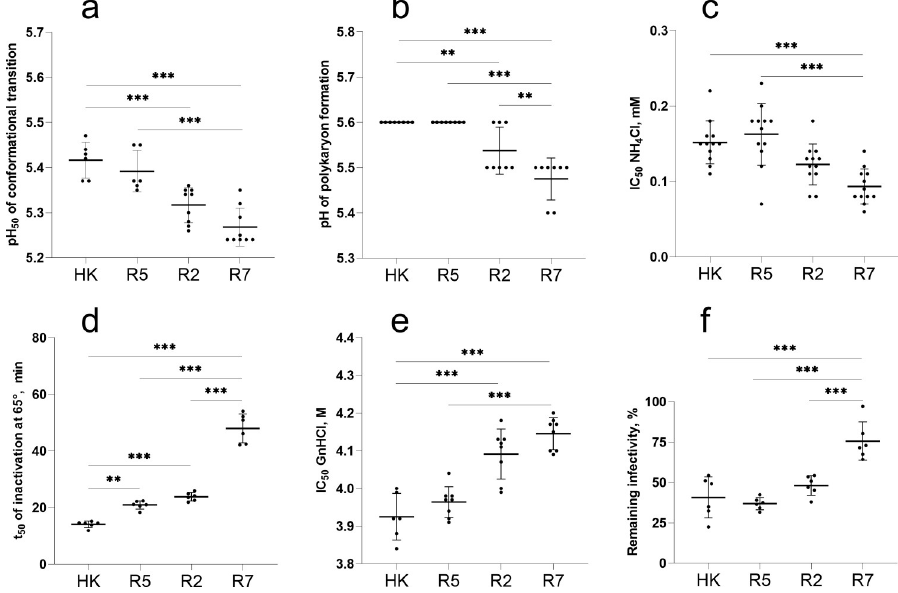
Fig 2. Conformational stability and membrane fusion properties of HK, R5, R2 and R7. ( a ) pH of acid-induced conformational transition of HA. Solid-phase adsorbed viruses were incubated in acidic buffers and treated with proteinase K. Viral binding of fet-HRP was assayed, and pH values that corresponded to 50% reduction of HA binding activity (pH 50 ) were determined from binding-versus-pH curves. ( b ) pH threshold of polykaryon formation. Inoculated MDCK cells were cultured for 16 h, treated with trypsin and exposed to different pH buffers. After returning to neutral medium and incubation for 3 h, the cells were fixed, stained and analysed under the microscope. The data show highest pH values at which polykaryon formation was detected. ( c ) Inhibition of viral infection by ammonium chloride. MDCK cells were inoculated in the presence of various concentrations of NH 4 Cl, incubated overnight, fixed, and immunostained for NP. Concentrations of NH 4 Cl that reduced numbers of infected cells by 50% (IC 50 ) were determined from dose-response curves. ( d ) HA stability at elevated temperature. Solid-phase adsorbed viruses were incubated in PBS at 65˚C for different time periods and assayed for their binding to fet-HRP to determine incubation time required for 50% reduction of the binding activity (t 50 ). ( e ) HA stability in chaotropic buffer. Solid- phase adsorbed viruses were incubated in buffers containing GnHCl for 60 min at 4˚C washed with PBS and assayed for binding to fet-HRP. Data show concentrations of GnHCl that reduced viral binding activity by 50%. ( f ) Reduction of infectivity after incubation of the viruses for 2 h at 45˚C determined by focus assay in MDCK cells. All panels show data points, mean values and SDs from 1 to 4 independent experiments performed with 2 to 7 replicates. P values for the differences between the viruses were determined with Tukey’s multiple comparison